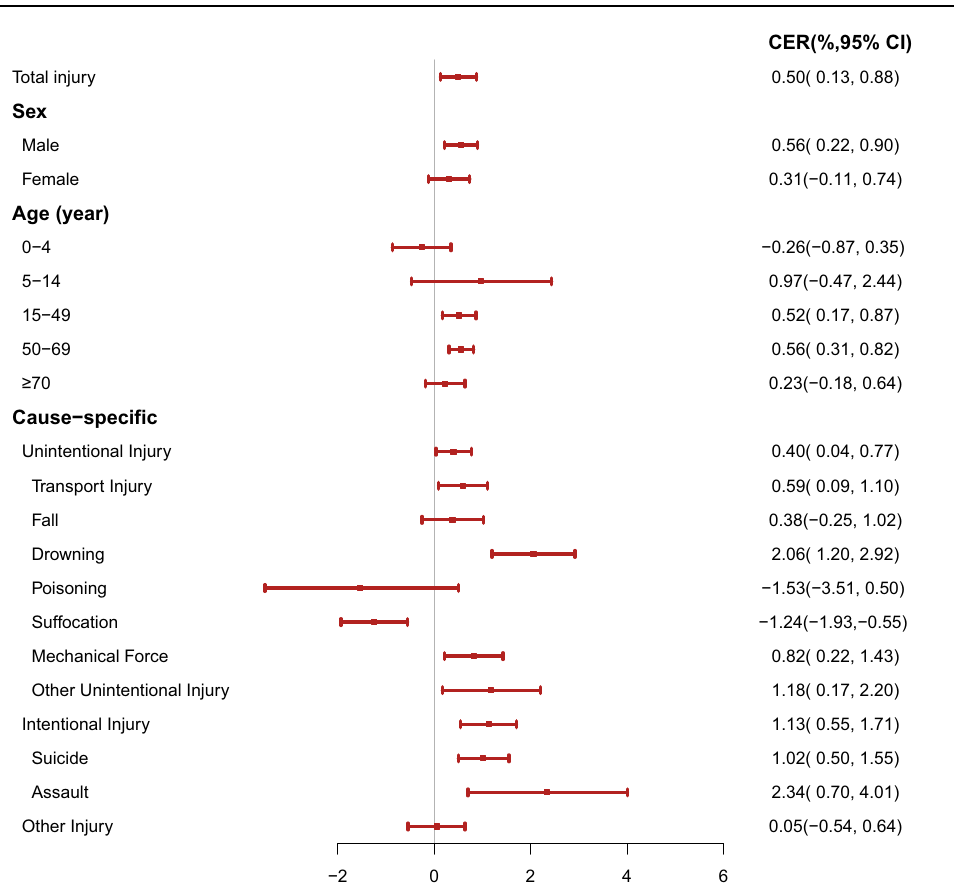
adjustedfor relative humidity, PM 2.5 concentrationand publicholiday,which were pooled in a multivariate meta-analysis. The statistical tests were two-sided. CER, cumulative excess risk. N =609827 independent samples of injury deaths were used to conduct 20 independent models; the exact sample sizes are shown